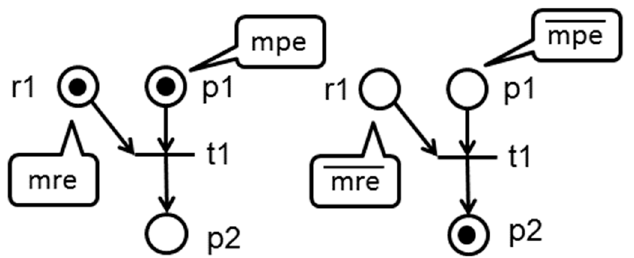
Figure 1. Marking of enabled and disabled resources and places.